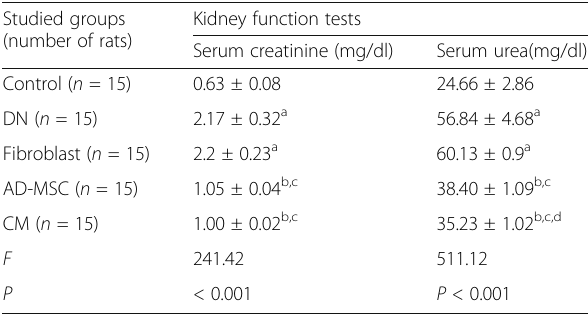
Table 2 Kidney functions assessment in the different studied rats ’ groups Studied groups (number of